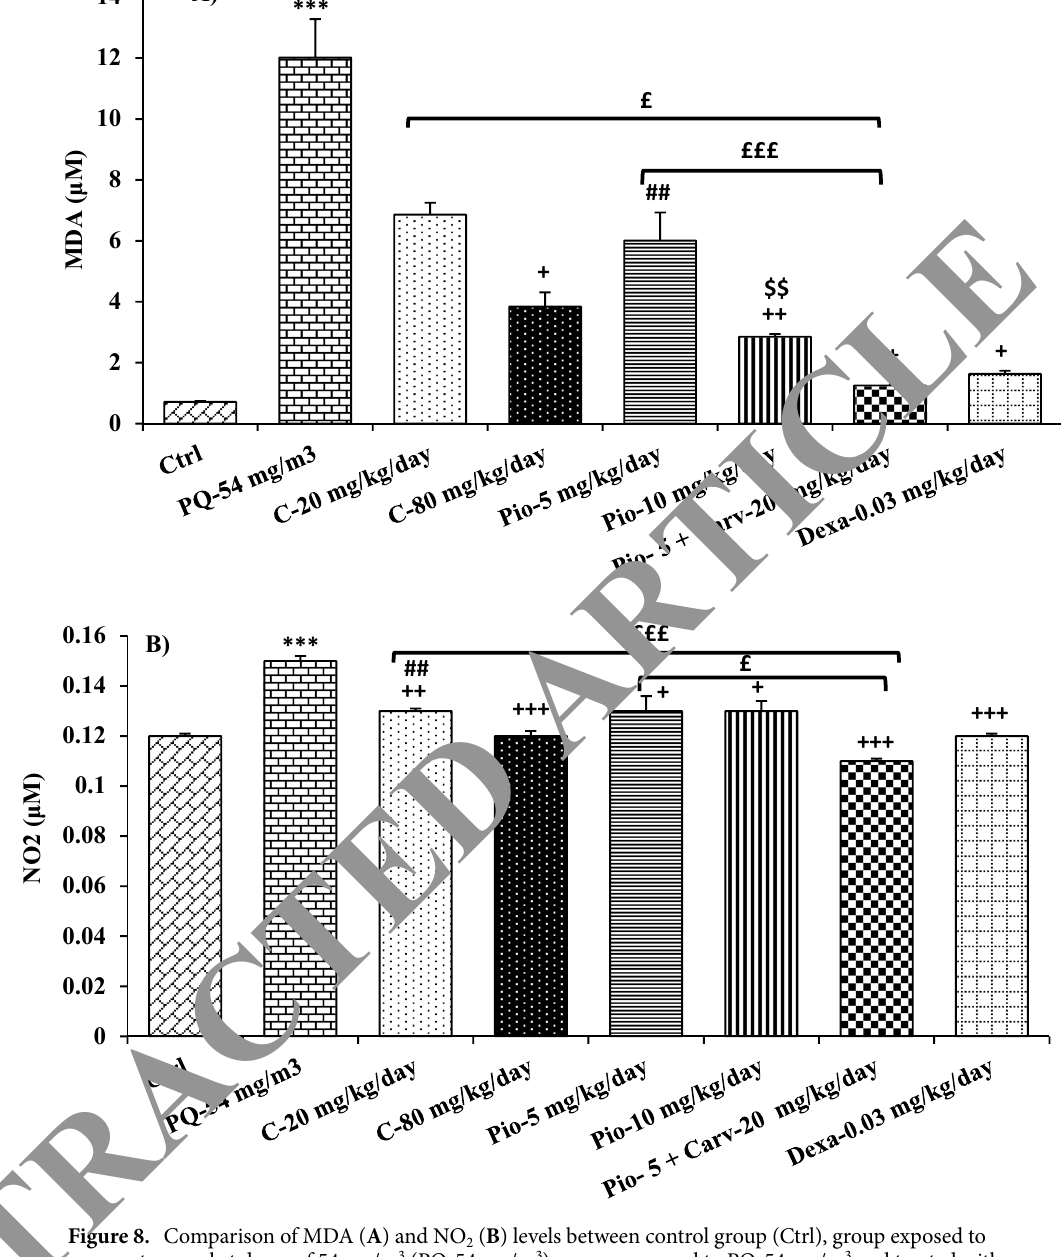
Figure 8. Comparison of MDA ( A ) and NO 2 ( B ) levels between control group (Ctrl), group exposed to paraquat aerosol at doses of 54 mg/m 3 (PQ-54 mg/m 3 ), groups exposed to PQ-54 mg/m 3 and treated with 5 and 10 mg/kg/day pioglitazone (Pio-5 mg/kg/day and Pio-10 mg/kg/day), 20 and 80 mg/kg/day carvacrol (C-20 mg/kg/day and C-80 mg/kg/day), 0.03 mg/kg/day dexamethasone (Dexa-0.03 mg/kg/day) and 5 mg/ kg/day pioglitazone + 20 mg/kg/day carvacrol (Pio-5 mg/kg + C-20 mg/kg). *** p < 0.001 compared to the control group. + p < 0.05, ++ p < 0.01, and +++ p < 0.001 compared to the PQ-54 mg/m 3 , ## p < 0.01 compared to dexamethasone, $$ p < 0.01 compared to Pio-5 mg/kg/day, £ p < 0.05 and £££ p < 0.001comparison between Pio-5 and C-20 with Pio-5 mg/kg/day + C-20 mg/kg/day group. Data are presented as mean ± SEM (n = 6 in each group). Comparisons between different groups were made using one-way ANOVA followed by Tukey’s multiple comparison mice 26 , induced lung pathological changes 28 days after PQ administration in Wistar rats 27 , and increased W/D of lung weight ratio, lung fibrosis as well as diminished arterial oxygen partial pressure, 7, 14, 21, and 28 days following PQ administration 28 . Several previous studies support the effects of PQ on the lung as observed in the current study. Increased total protein of the lung tissue and serious histopathological changes in the lung tissue were shown due to admin- istration of 20 mg/kg, i.p PQ for 3 days 29 . Administration of PQ (15 mg/kg/mL, i.p.) increased lung fibrosis, transforming growth factor-1β (TGF-1β) and malondialdehyde (MDA) levels in the lung as well as neopterin and